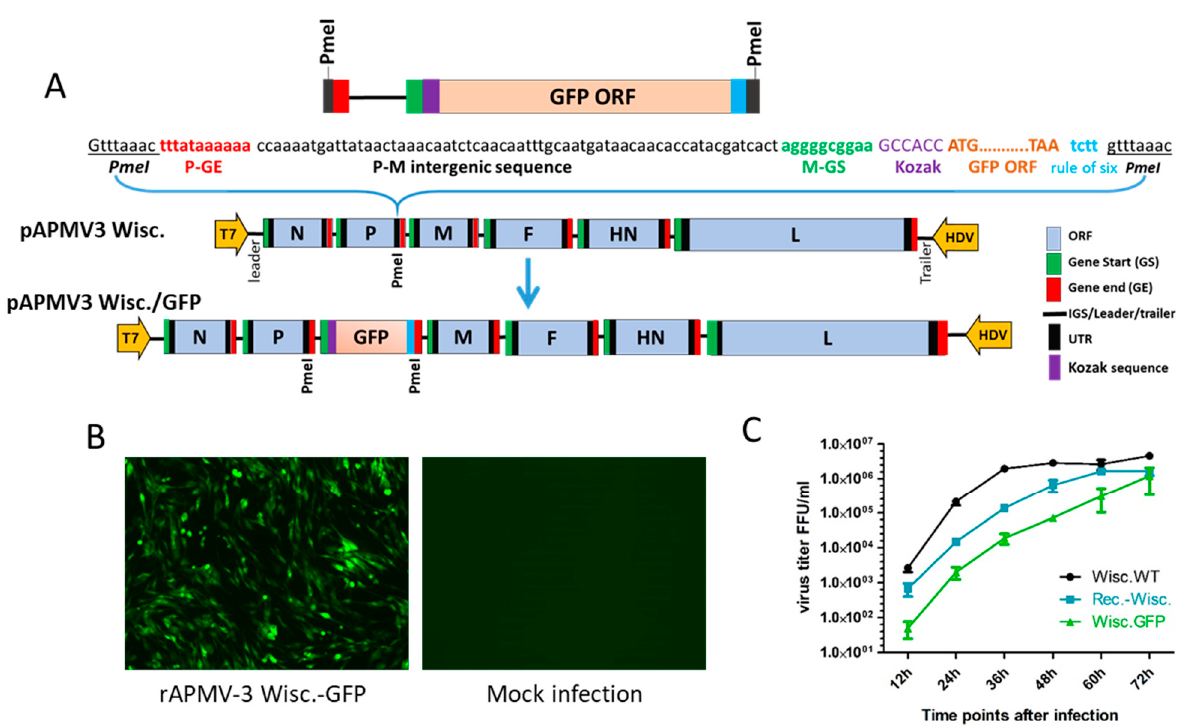
Figure 2. Construction of recombinant APMV-3 Wisc. expressing green fluorescent protein (GFP). ( A ) GFP gene cassette was constructed by including P gene-end, P-M intergenic sequence, M gene-start, and Kozak sequence for enhanced translation. The GFP cassette was cloned between P and M genes at the PmeI site. The full length cDNA clone was termed pAPMV3 Wisc.\GFP. ( B ) GFP expression by recombinant APMV-3 Wisc.\GFP (rAPMV-3 Wisc.\GFP) in DF-1 cells two days post-infection. ( C ) Multicycle growth kinetics of wild type APMV-3 Wisc., rAPMV-3 Wisc., and rAPMV-3 Wisc.\GFP in DF-1 cells using 0.01 multiplicity of infection for each virus. The virus titers were calculated as a mean of two different growth kinetics experiments in FFU/mL.